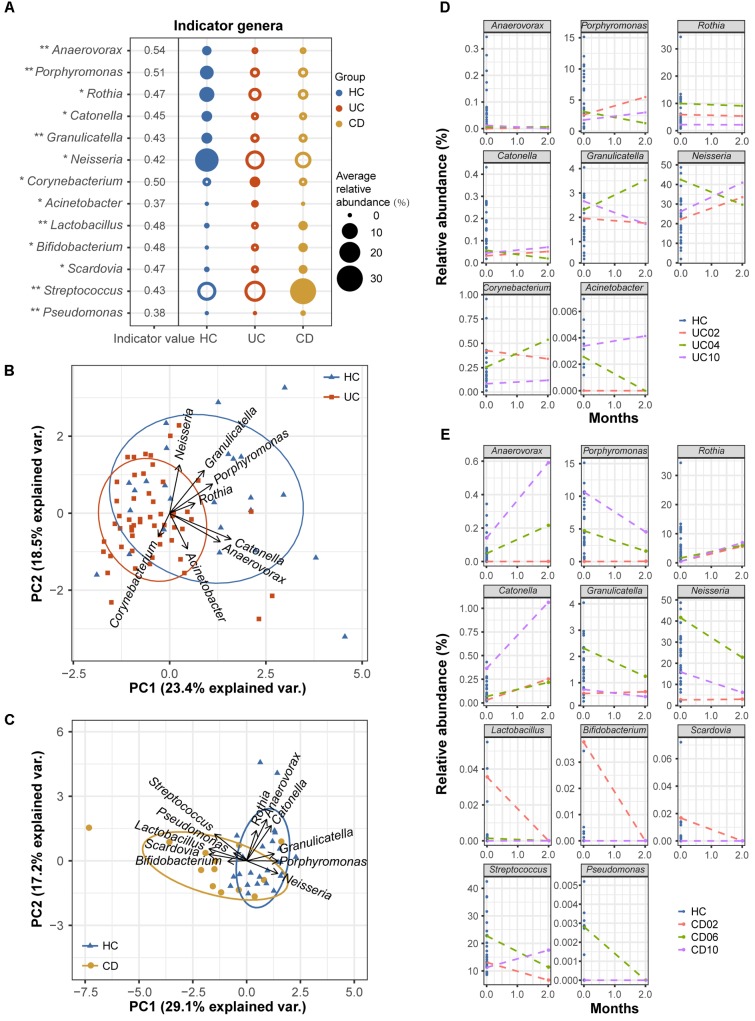
Indicator genera characterizing the UC, CD and HC bacterial communities. (A) Indicator species analysis based on the normalized abundances of the genus profile was performed (54 UC, 13 CD, and 25 HC baseline samples). Indicator genera corresponding to each group are designated by solid circles. Corresponding indicator values and their P-values are also reported next to the name of the taxon (∗∗ indicates P < 0.01, and ∗ indicates P < 0.05). Indicator values (IV) range from zero to one, with larger values denoting stronger indictors. Only indicators with significant P-values are shown. (B) The separation of UC and HC samples is shown in the PCA biplot using UC- and HC-associated indicator genera. (C) The separation of CD patients and HCs is shown using their associated indicator genera. Temporal variation patterns of the above indicators in (D) three UC and (E) three CD patients with active diseases. The horizontal axis of each plot represents the months from study entry and the vertical axis represents the relative abundances of the indicators. Samples from baseline and after 2 months of standard therapy were used to examine variations. Baseline samples from healthy controls are shown as references.